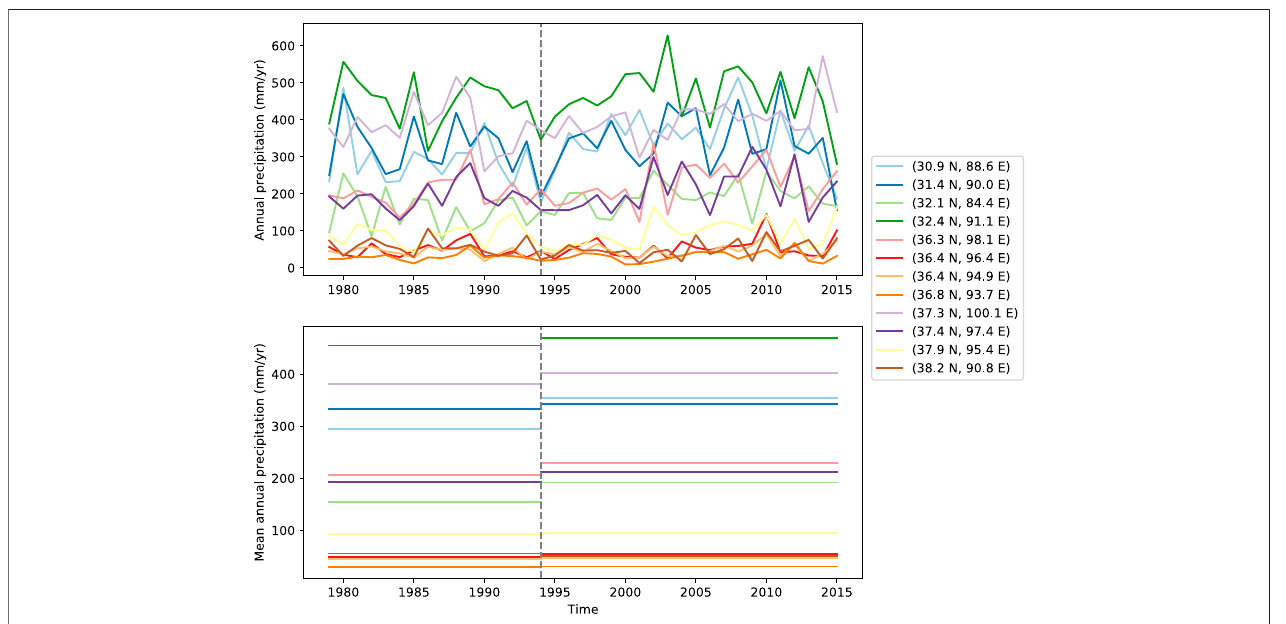
FIGURE 9 | Annual precipitation (upper panel) and mean annual precipitation (lower panel) for the twelve China Meteorological Association stations located within the study region. Additionally, fi gure S7 shows the inter-annual variability of precipitation for each station.